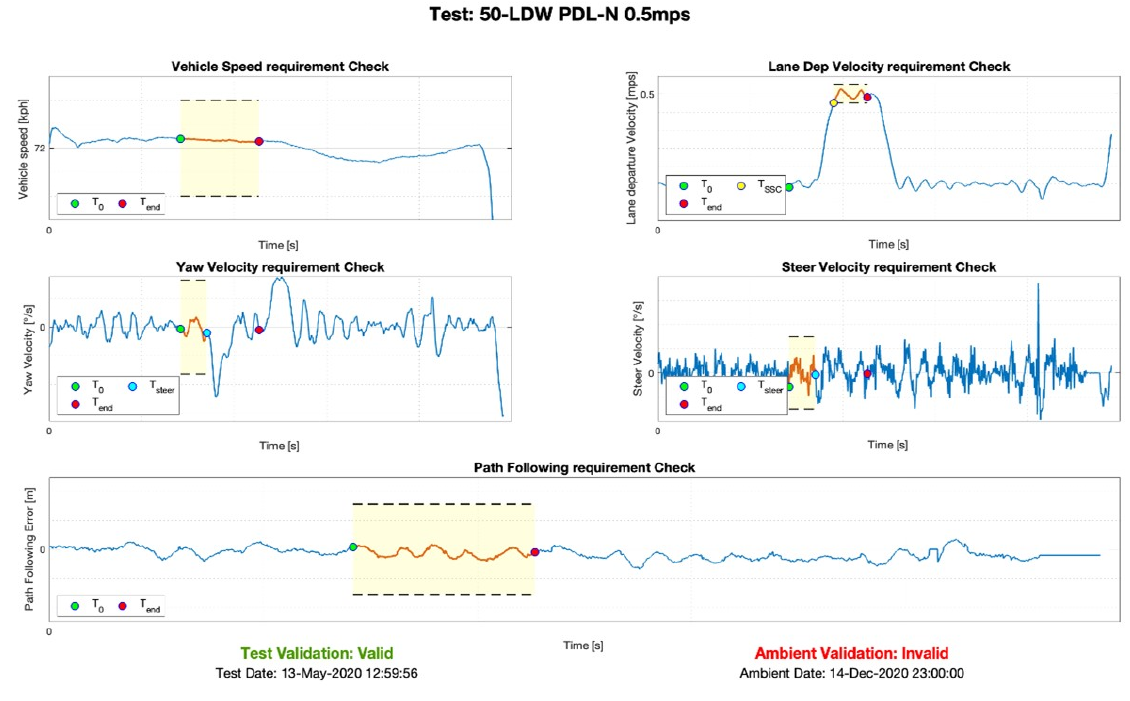
Figure 15. Post-processing results for a valid test LDW.